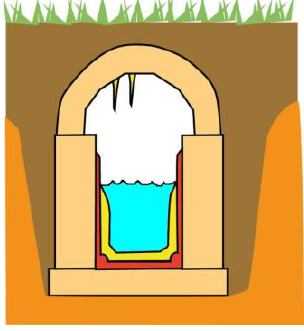
Figure 10. Cross-section of a Roman aqueduct channel constructed with bricks below the Earth ’ s surface. The inside of the channel was covered with reddish waterproof cement ( opus signinum — in red), with a distinctive seal on the edges. Some channels have carbonate deposits (yellow) due to the hard water transported by aqueducts in some regions [60,65].